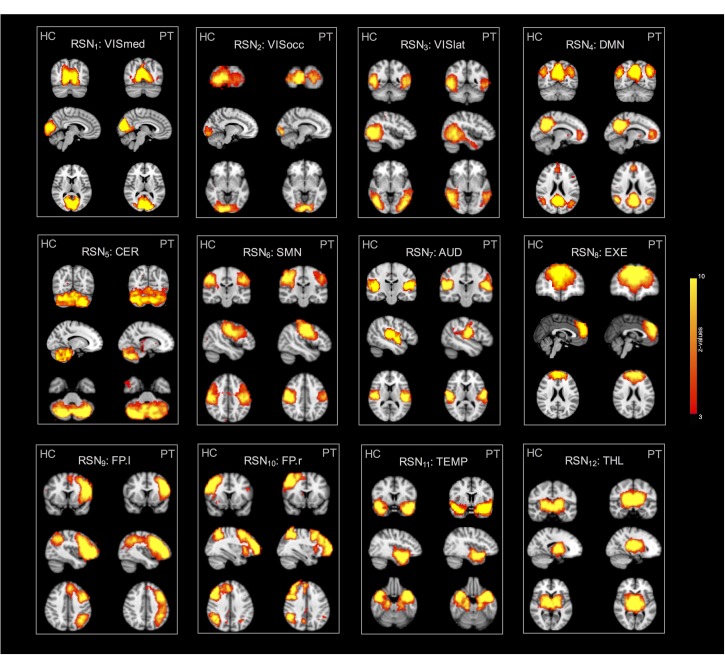
Twelve resting-state networks (RSNs) of interest derived from the control and patient group analyses. All spatial maps were converted to z-statistic images and thresholded at z = 3. Each map was superimposed to the 2-mm MNI152 standard space and shown in radiological convention.